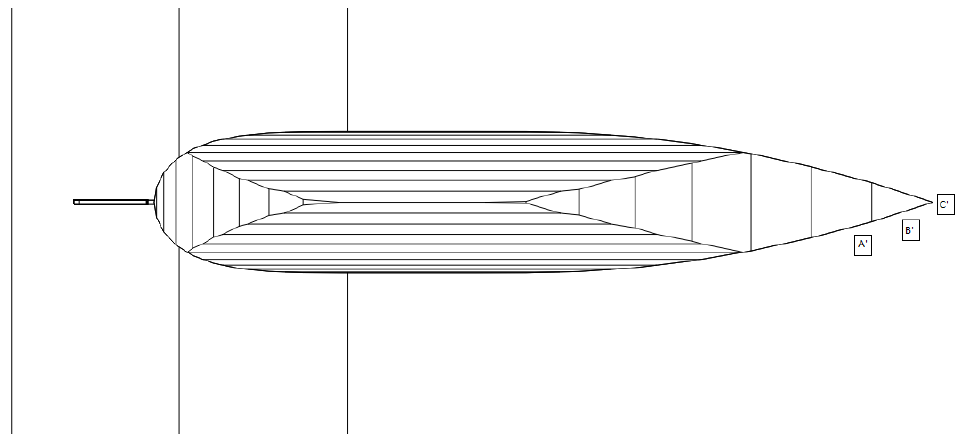
Figure 12. The diagram of the three points in the tail of the sail hull.